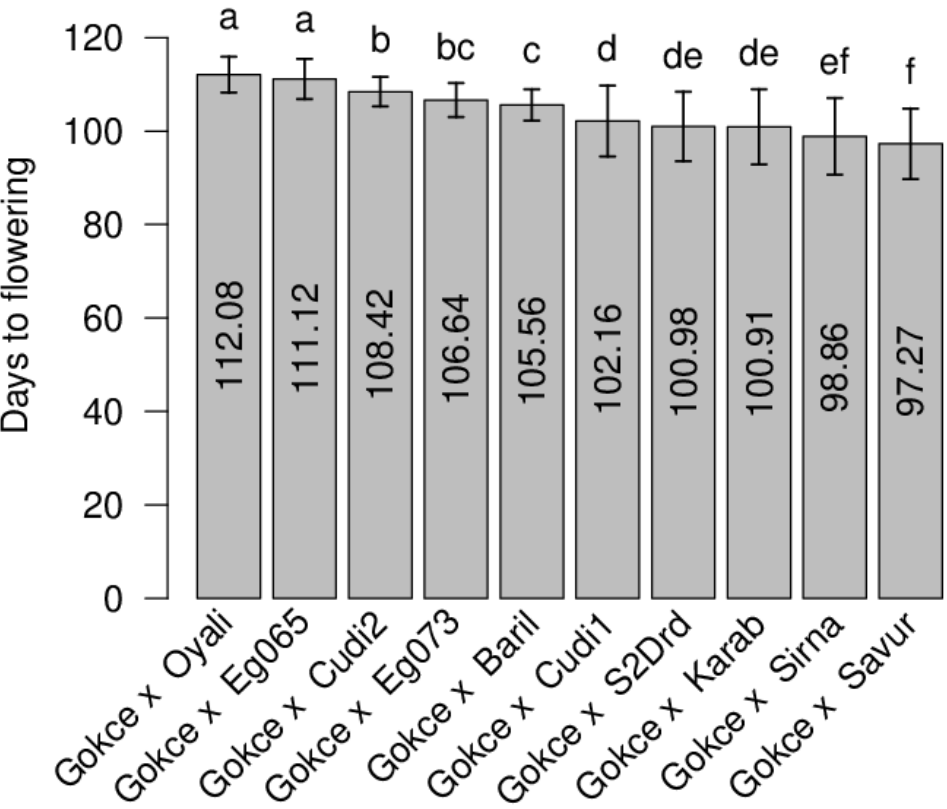
Figure 2. Mean of days to first flowering comparison between ten chickpea NAM populations. Grey bars show the mean values per population. Error bars are the standard deviations. Letters refer to the results of Tukey’s HSD tests indicating six distinct levels. Table 3. Results of goodness-of-fit chi-square tests ( χ 2 ) for best fit to one-, two-, or three-gene models for the flowering time of chickpea NAM populations. NS: non-significant at a 5% significance level. Bold highlighted rows indicate the preferred gene model for each